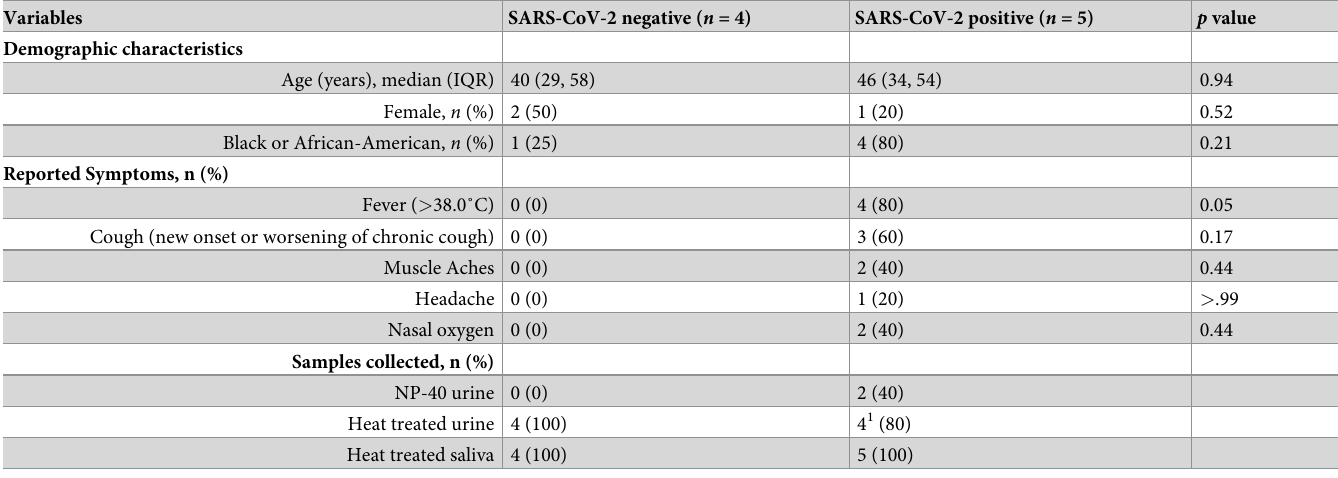
Table 3. Adult demographic and clinical characteristics for urine and saliva